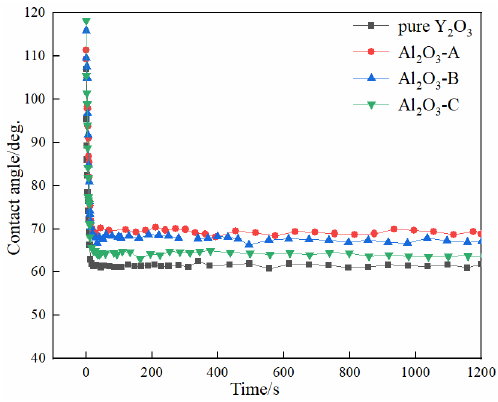
Figure 9. Variation of contact angle with time at 1873 K.